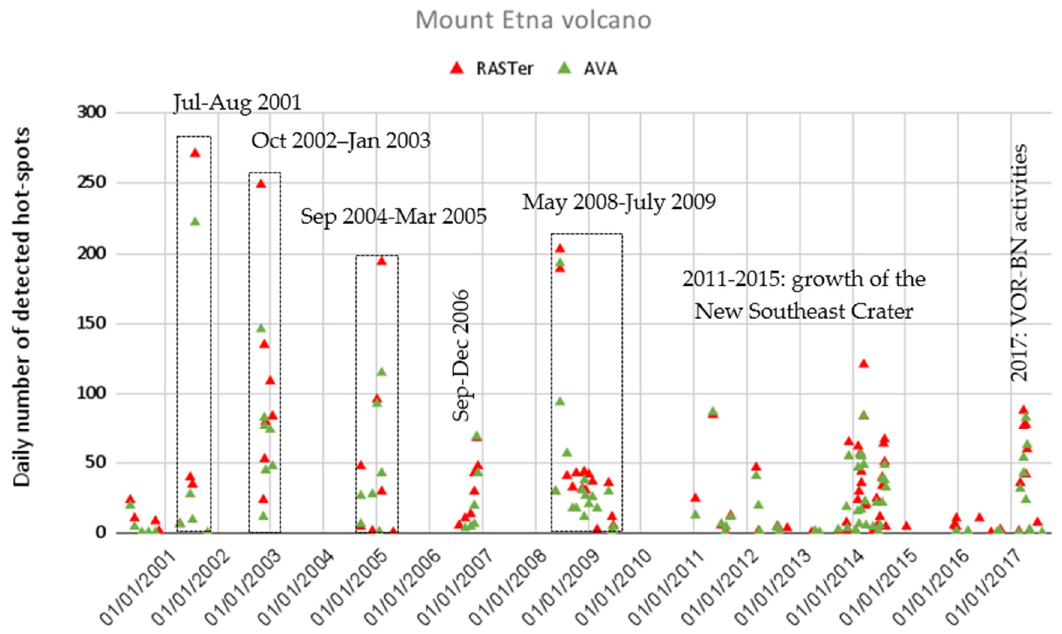
Figure 1. Time series (2000–2017) of the daily number of hot pixels flagged by RASTer and AVA at Mt. Etna. Dotted black rectangles indicate the periods of Mt. Etna flank eruptions; these eruptive events show the highest daily number of hotspots. The intense explosive and effusive activity at the Southeast Crater is also highlighted in the period September–December 2006. Similarly, the birth and growth of the New Southeast Crater in 2011–2015 is shown on the right side of the diagram. Finally, a significant number of hotspots characterized Strombolian activity in 2017, mainly at the Voragine (VOR) and Bocca Nuova (BN)